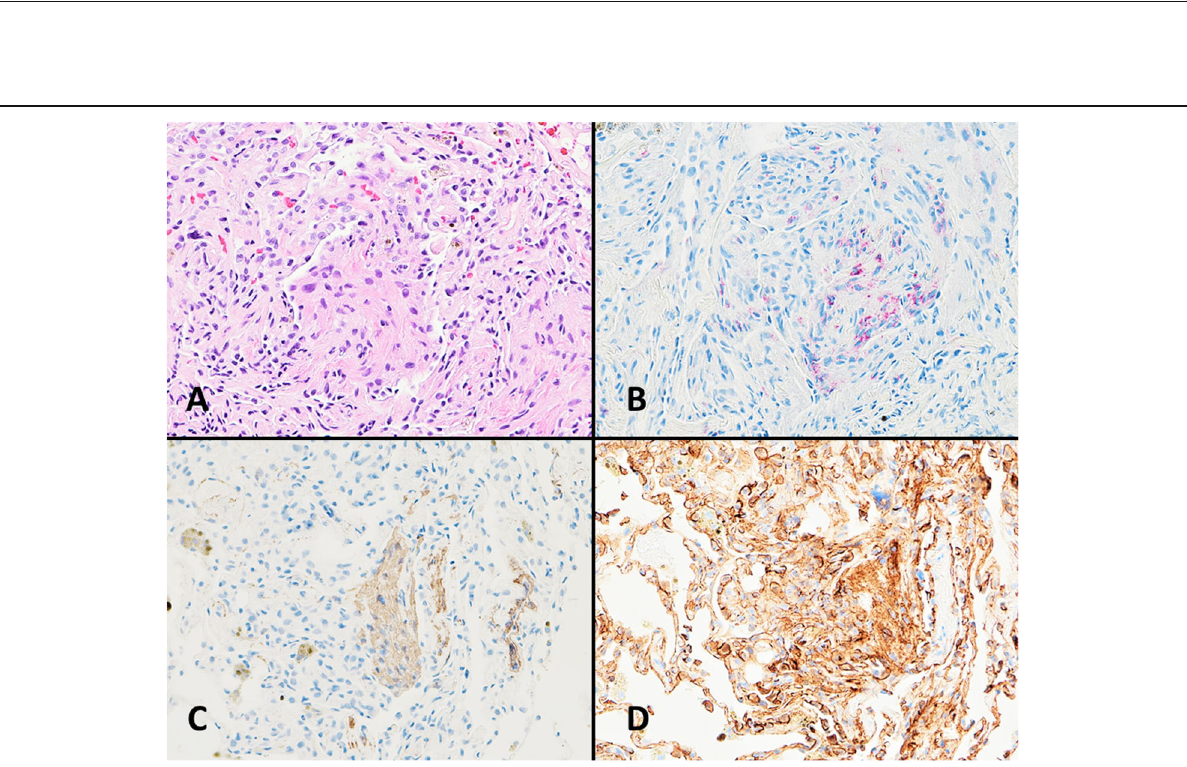
Fig. 3 Transbronchial biopsy of the lung allograft shows atypical spindle cell proliferation (dotted circle). The abnormal spindle cells are larger than that of the smooth muscle cells in the nearby arteries and bronchioles (hematoxylin and eosin, original magnification 40X)